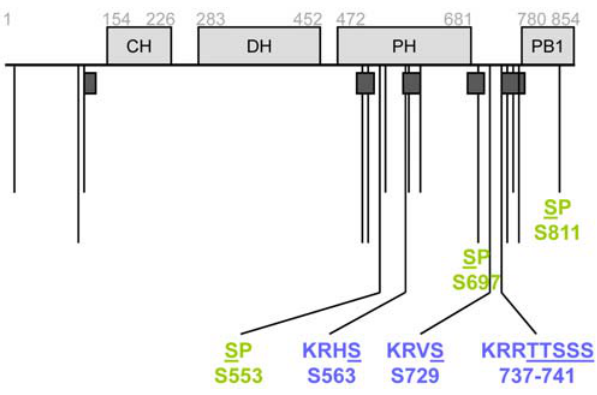
Figure 1. Cdc24 is phosphorylated on 35 residues. Schematic diagram of Cdc24 domain structure, regions of low complexity, and mapped phosphorylation sites. Regions of low complexity are denoted by the dark gray boxes under domains and correspond to residues 106– 121, 523–545, 562–600, 680–710, 739–754, and 767–778. Adjacent residues were grouped together to facilitate analysis. Longer lines correspond to more highly ranked sites. Labeled in green are CDK consensus sites and in blue are PAK consensus sites. See Tables S1–S3 for details on sites and ranking information. CH, calponin homology; DH, Dbl homology; PH, pleckstrin homology; PB1, p67 phox -Bem1